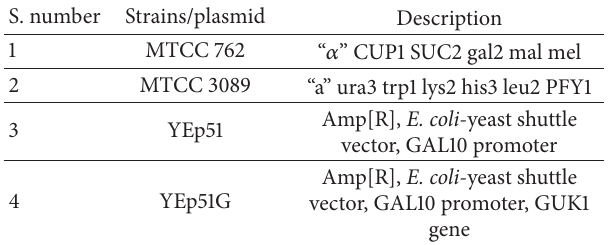
Table 2: Strains and plasmids used for gene amplification